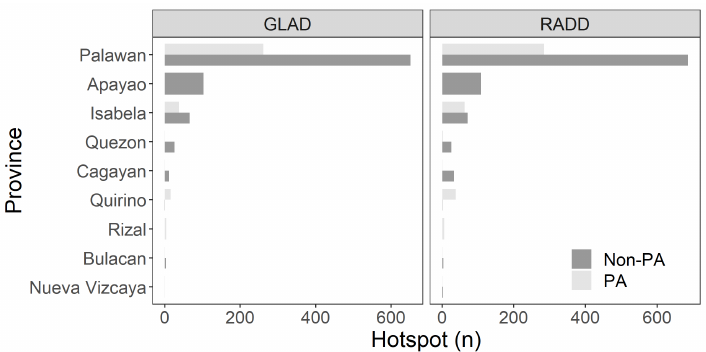
Figure 4. Hotspots in protected areas (PAs) and outside PAs (non-PAs) per province for both hotspot maps using GLAD and RADD alerts in